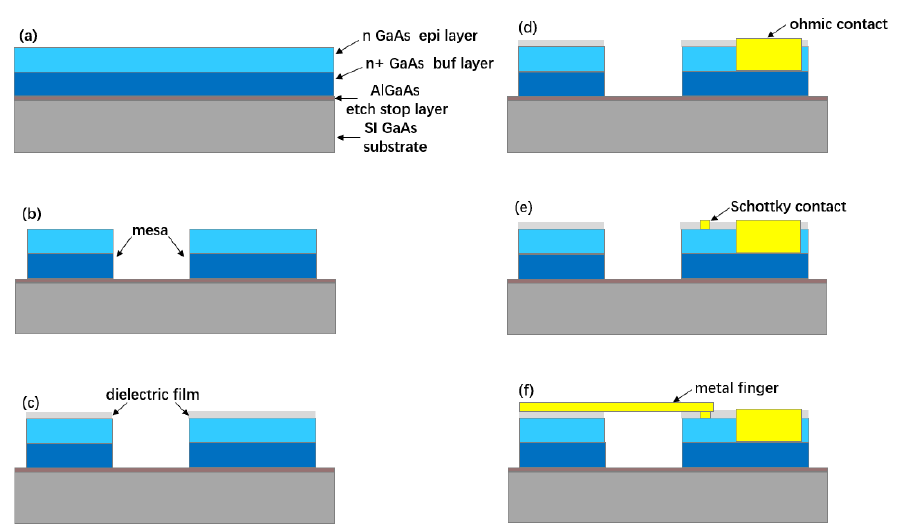
Figure 4. Schematic of the diode fabrication process for Schottky diodes. ( a ) Epitaxial preparation; ( b ) Mesa etching; ( c ) Passivation; ( d ) Making ohmic contact; ( e ) Making Schottky contact; ( f ) Making metal